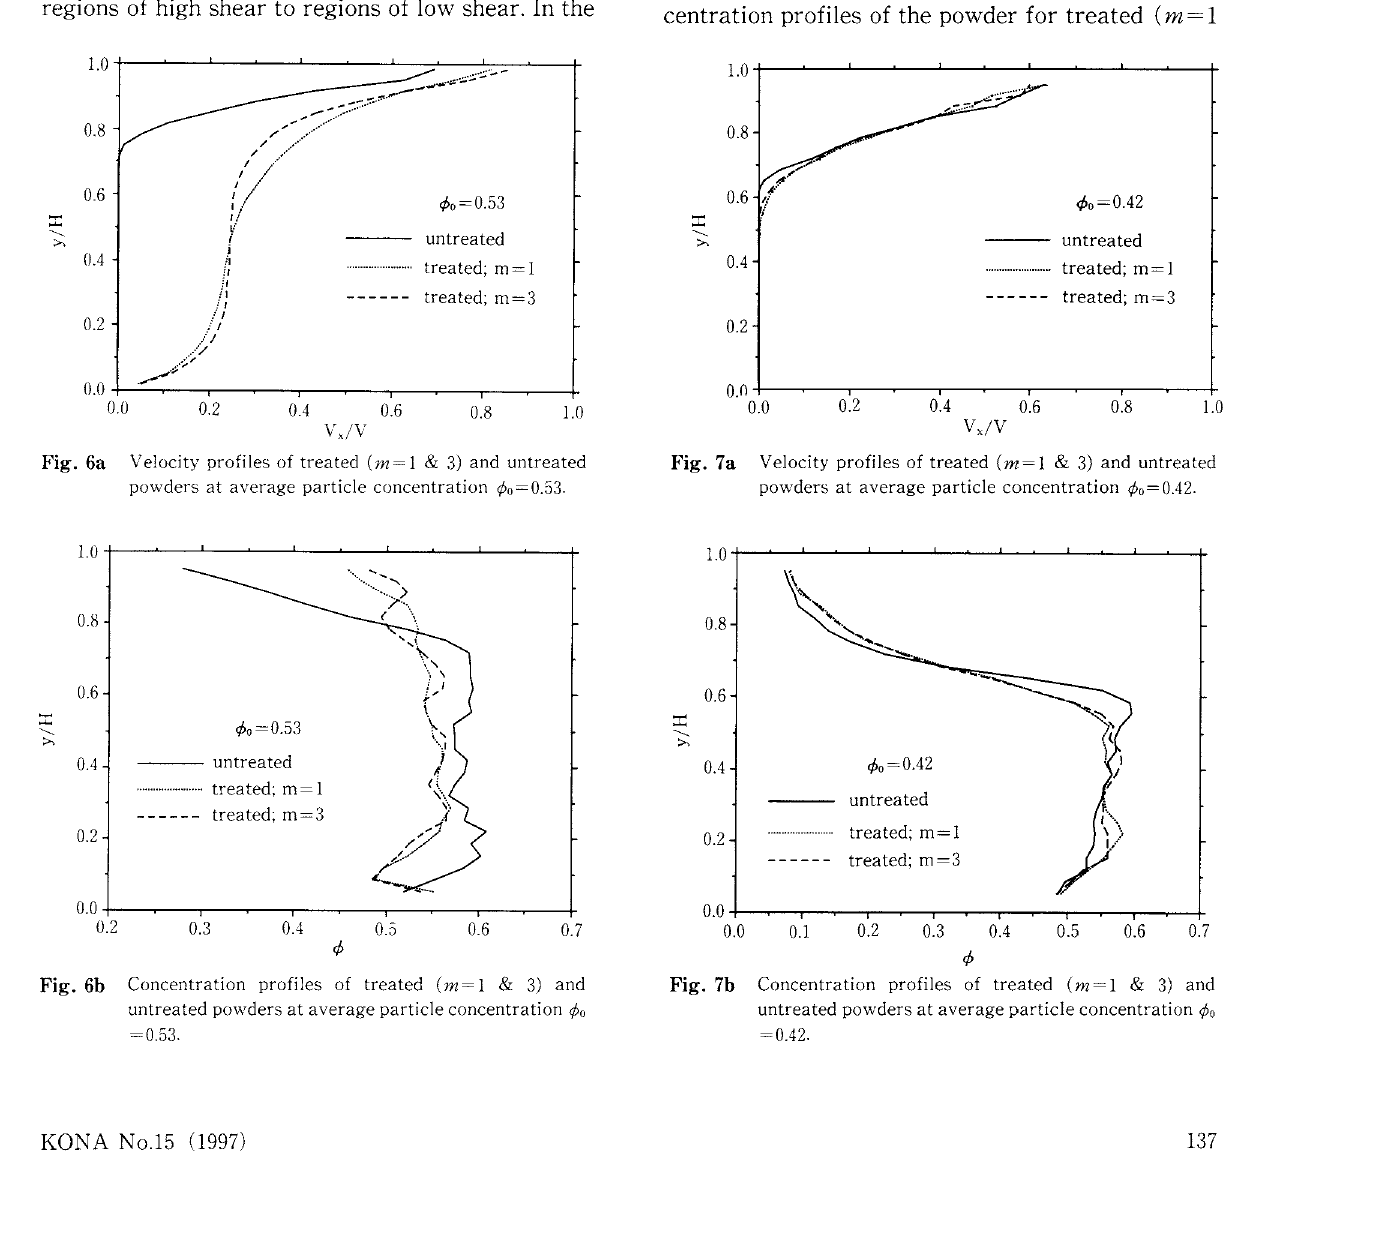
Fig. 7a Velocity profiles of treated (m=l & 3) and untreated powders at average particle concentration ¢ 0 = 0.42.